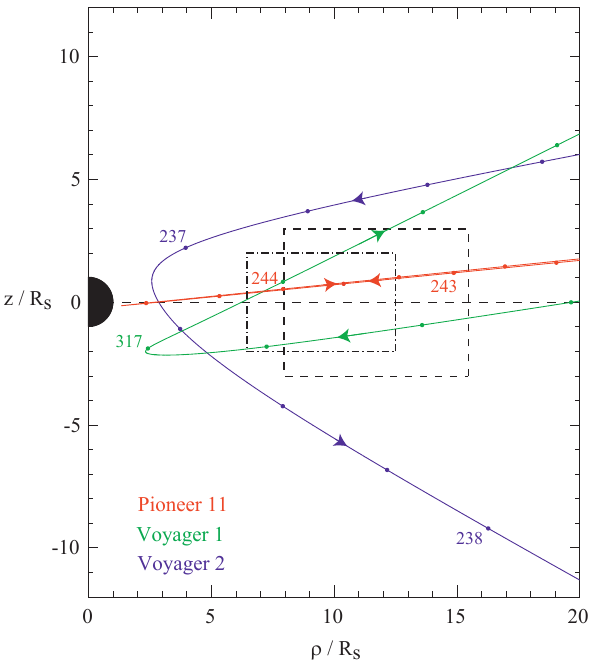
Fig. 2. Plot showing the trajectories of Pioneer-11, and Voyager-1 and -2 relative to Saturn in cylindrical coordinates. The horizontal axis shows the perpendicular distance from the planet’s spin (and magnetic axis), ρ , while the vertical axis shows the distance along this axis from the equatorial plane, z . These distances are given in units of Saturn’s radius, R S , taken to be 60330km. The tic-marks on the trajectories indicate 6-h intervals, while the arrows show the direction of motion of the spacecraft, which was essentially along the same path inbound as outbound for Pioneer-11. The dashed rectangle marks the ring current region modelled by Connerney et al. (1983) based on Voyager field data, which lies between 8 and 15.5 R S in ρ , and between − 3 and +3 R S in z . The dot-dashed rect- angle marks the ring current region modelled here using Pioneer-11 field data, which lies between 6.5 and 12.5 R S in ρ , and between − 2 and +2 R S in z